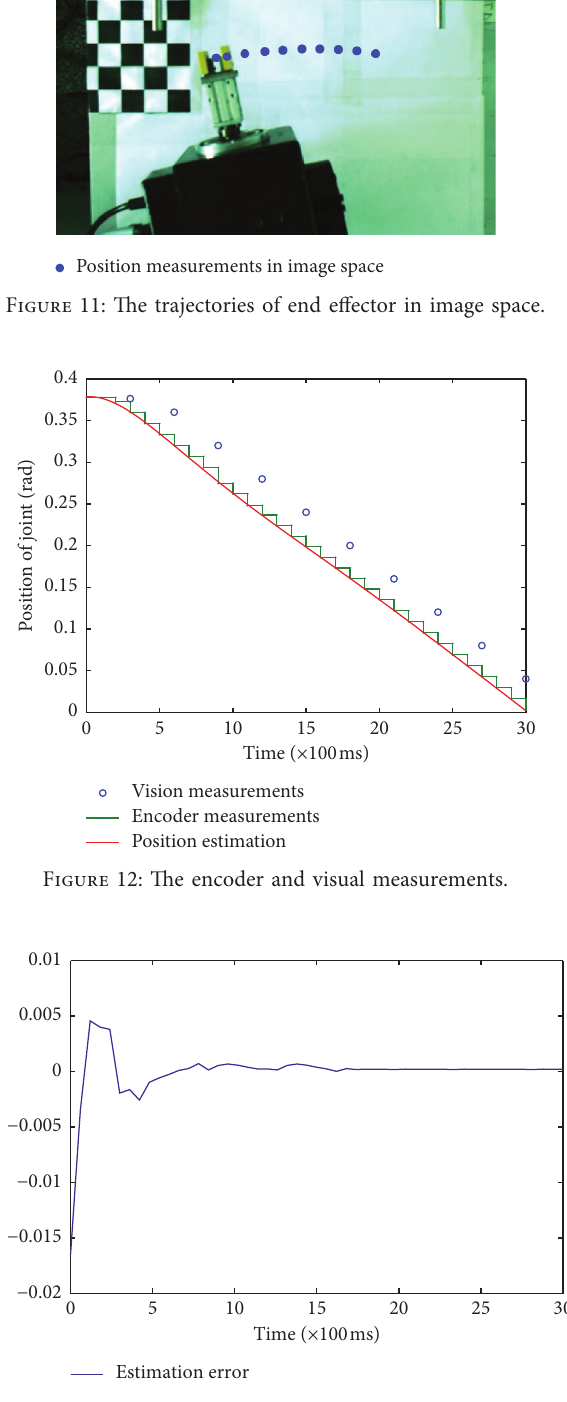
Figure 13: The position estimation error of the joint.